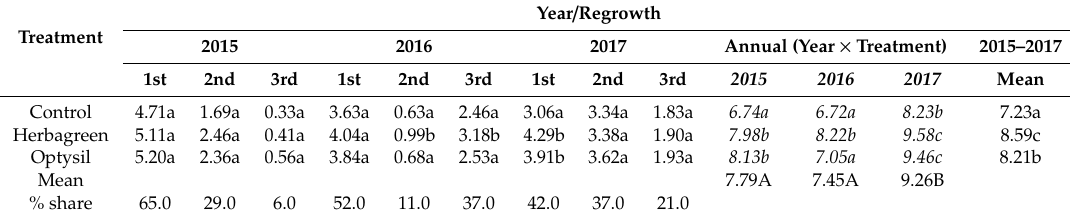
Table 2. The yield of dry matter of the grass–clover sward (YDM; t / ha) and their percentage share in annual yield (2015–2017) depending on the application of fertilizers containing silicon (Herbagreen, Optysil). Year / Treatment